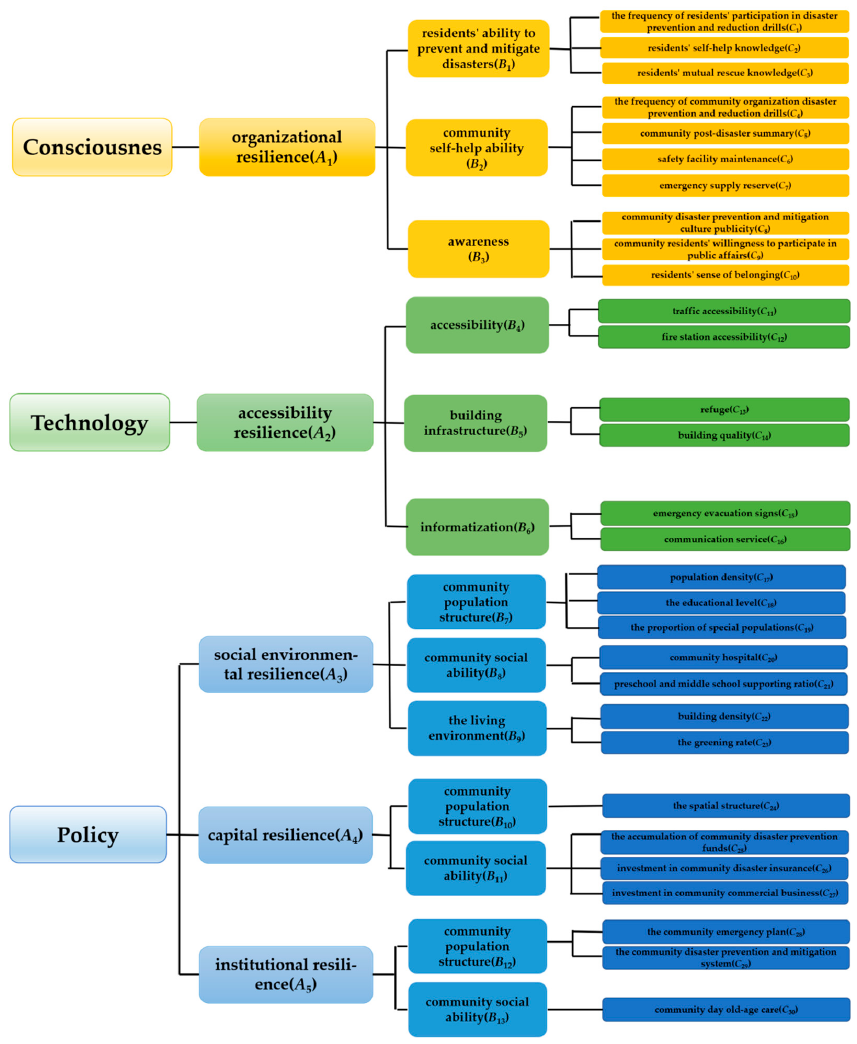
Figure 3. Safe community evaluation index